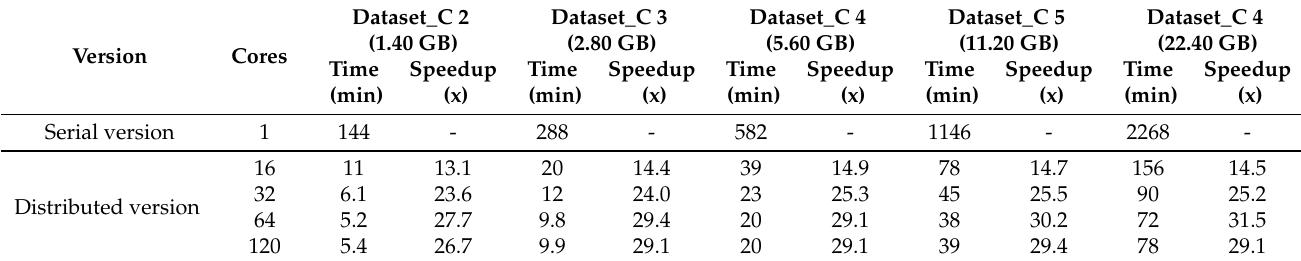
Table 2. Execution time and speedup of the serial and distributed parallel versions of PPI with dataset_C 2-6.